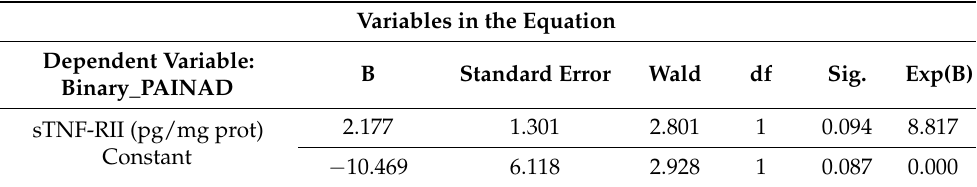
Table 2. Binary logistic model between the binary PAINAD variable and the sTNFR-II and sIgA levels. Variables in the Equation Dependent Variable: B Standard Binary_PAINAD